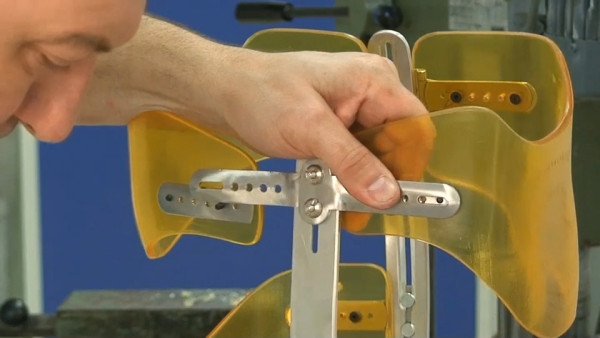
Metallic plates.